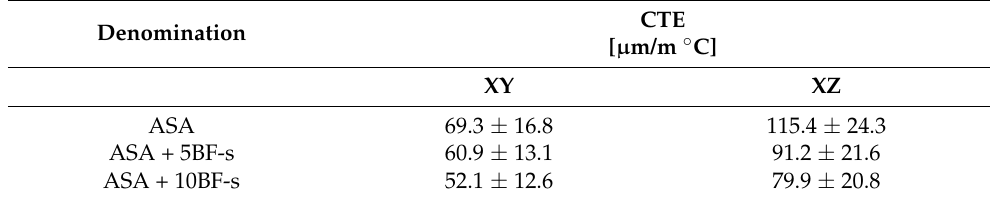
Table 4. CTE of ASA, ASA + 5BF-s and ASA + 10BF-s in the linear region of 40–70 ◦ C printed in XY and XZ orientation.